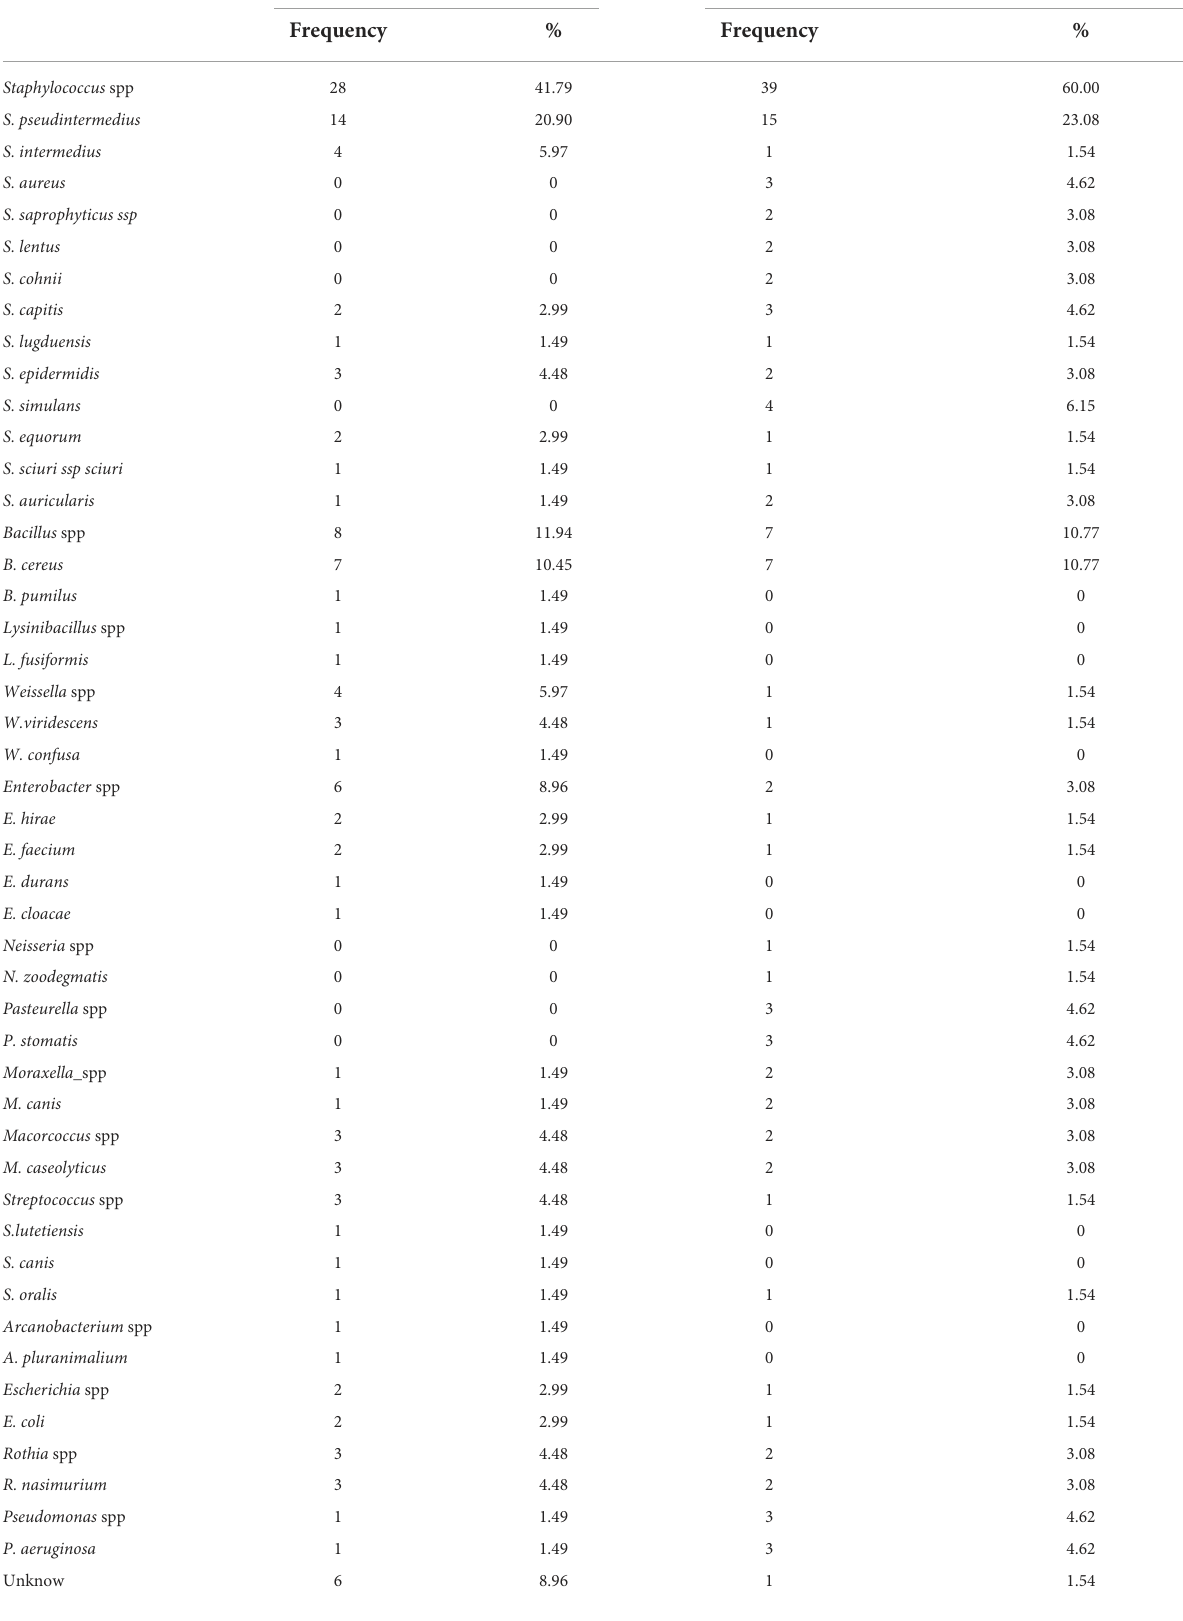
TABLE 2 Bacterial species isolated from canine conjunctival sac. Organism Clinical healthy